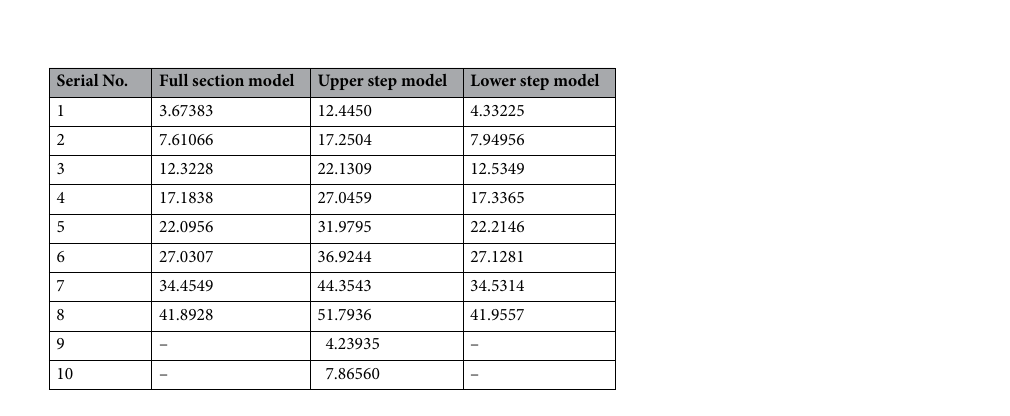
Table 6. Calculation of blast distance at monitoring point (units: m).